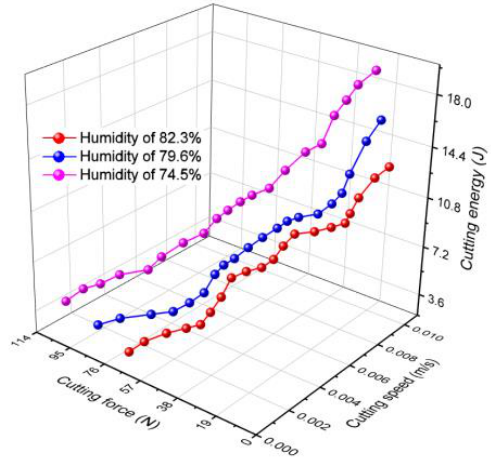
Figure 6. Variation in cutting energy for peeled potatoes with different humidity levels as a function of cutting speed.